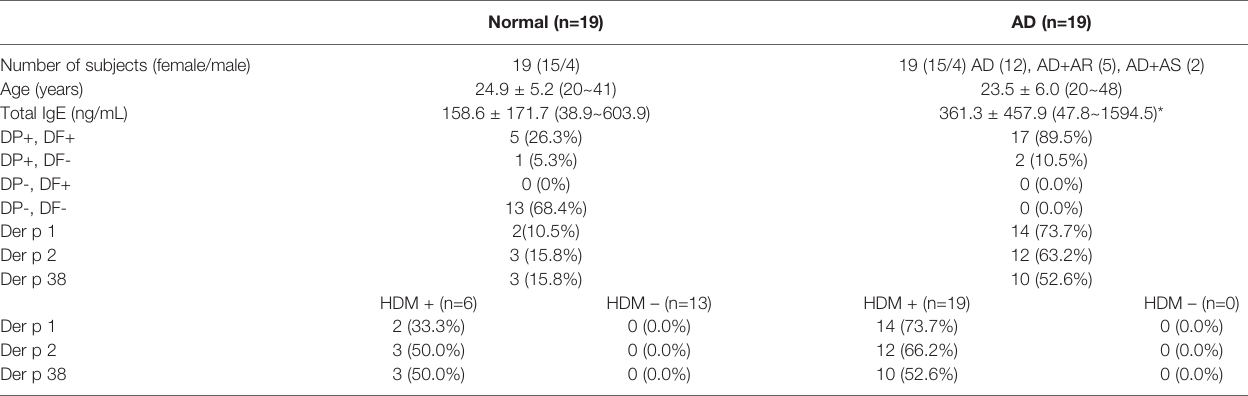
TABLE 1 | Demographic and clinical characteristics of normal and AD